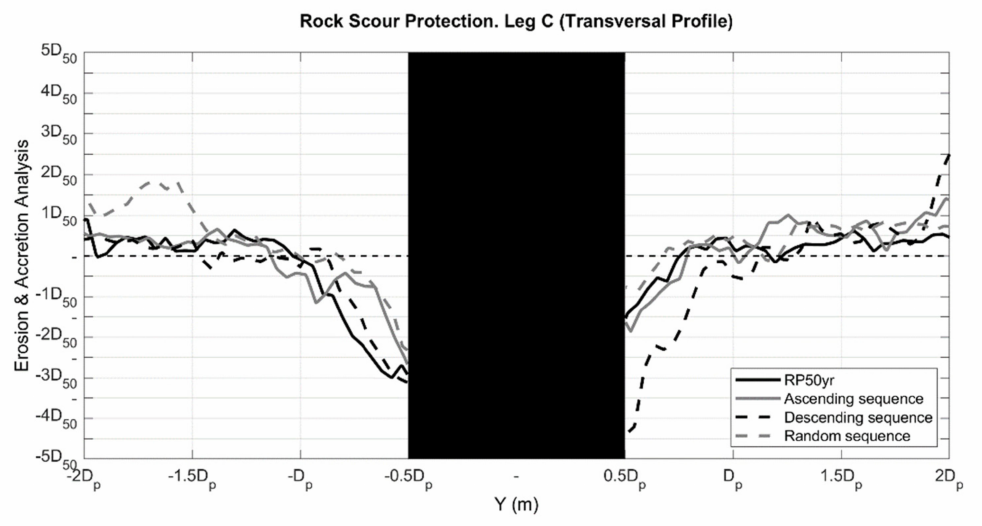
Figure 12. Leg C: cross-sectional